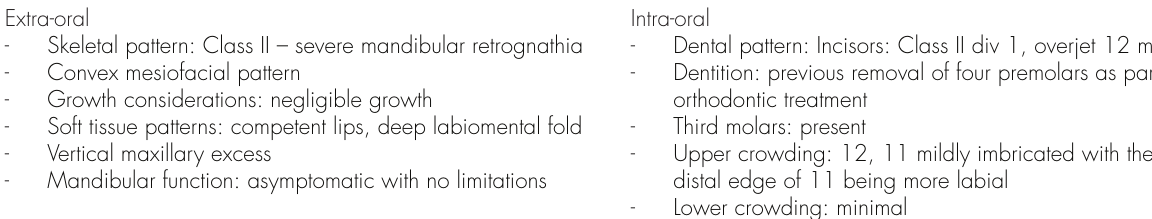
Table I. Extra- and intra-oral assessment with ICR presentation in May 2016.